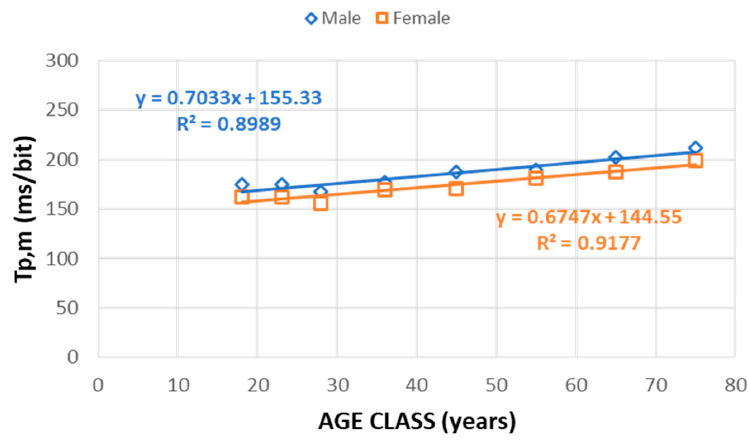
Figure 4. T p,m values influenced by age and sex in case of motor tasks.